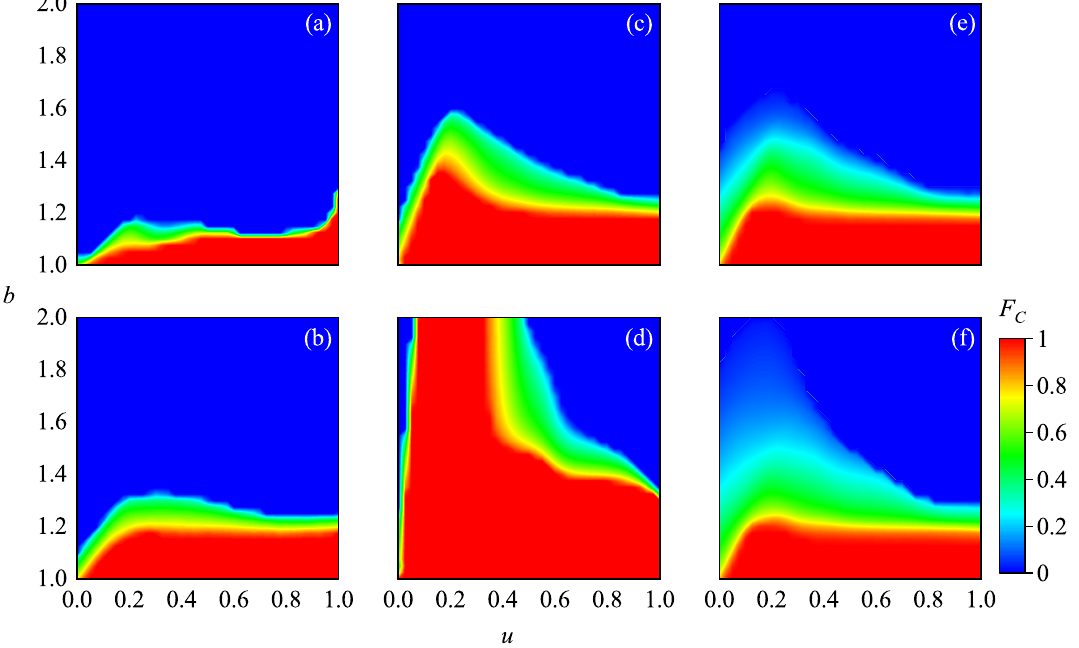
Figure 5. The color map encodes the stationary fraction of cooperators in dependence on the temptation to defect T and the punishment factor u . panel ( a – d ) are obtained with parameter α = 0, 0.3, 0.6, 0.9 , respectively. Panel ( e , f ) are obtained on regular small world networks and regular random networks for α = 0.5 . All the results obtained with L = 200